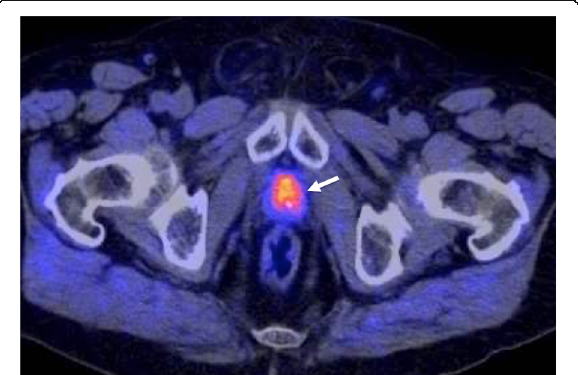
Fig. 12 An axial 18 F-Choline PET/CT image depicted a mass in the prostate bed (white arrow) in a 72-year-old man with a biochemical relapse of a prostate cancer following radical